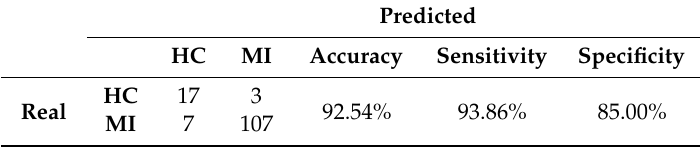
Table 2. The performance of Bi-LSTM without the heartbeat-attention mechanism (Experiment 1).